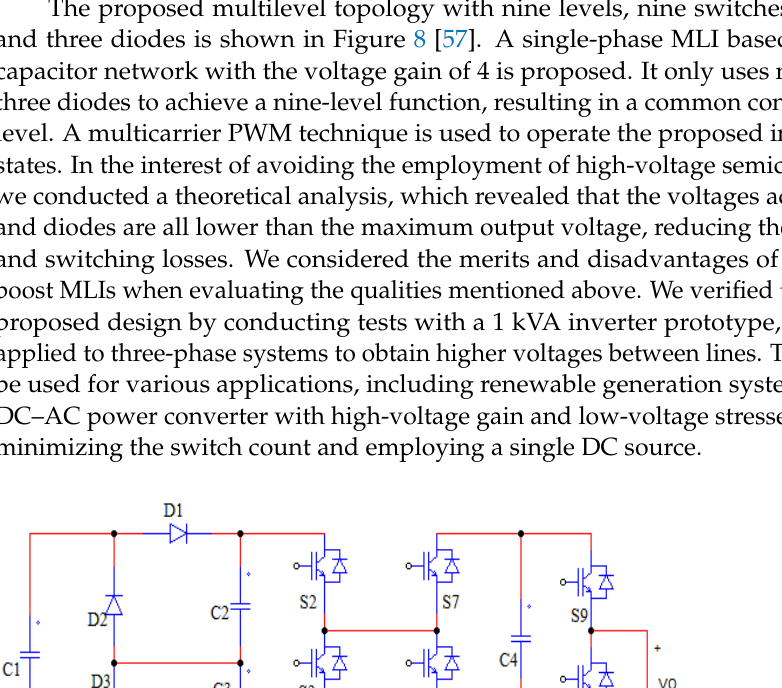
Figure 7. Eight-switch, nine-level topology [56].